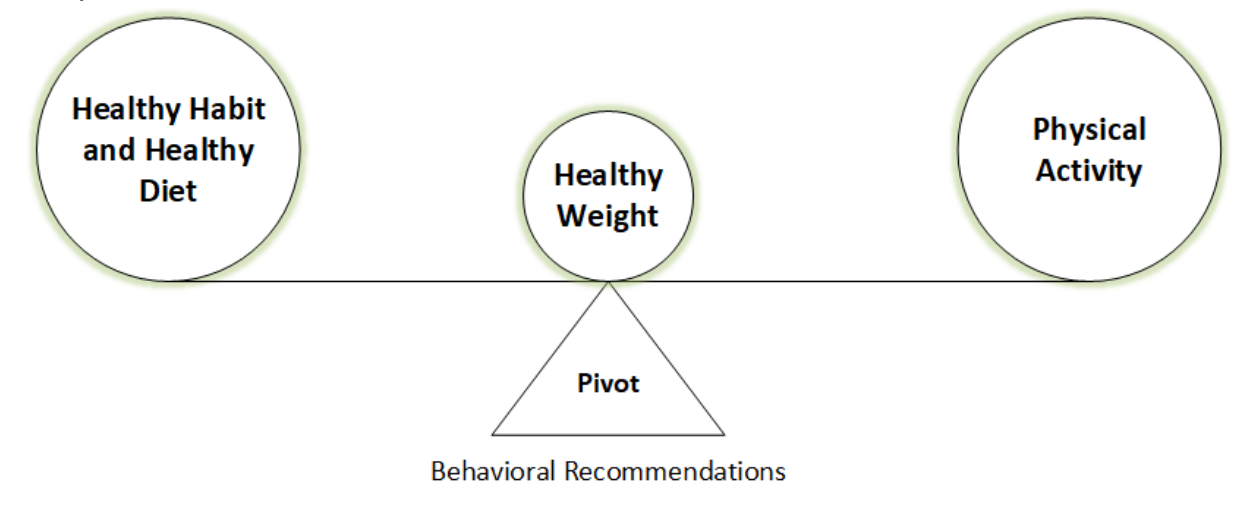
Figure 18. Behavioral recommendation generation (pivot) for the management of healthy lifestyle (a trade-off between physical activity, healthy habit, and healthy diet).